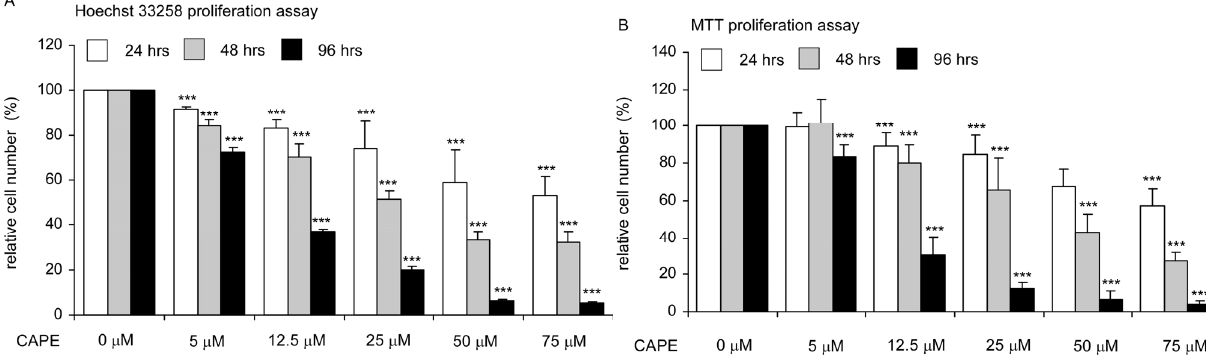
Figure 1. Effect of caffeic acid phenethyl ester (CAPE) on viability and proliferation of TW2.6 oral cancer cells. TW2.6 oral cancer cells were treated with increasing concentrations of CAPE for 24, 48, or 96 h and determined by Hoechst dye 33258-based 96-well proliferation assay ( A ) or by MTT (3,4,5-dimethylthiazol-2-yl)-2-5-diphenyltetrazolium bromide) 96-well assay ( B ), respectively, as described in Material and Methods. Cell numbers were normalized to control (DMSO treatment) of each treatment period. The mean and standard deviation represented the average and standard deviation respectively of the results from all 36 wells in the three experiments. Asterisk *** represents statistically significant difference p < 0.001 between the treated group and the control group.